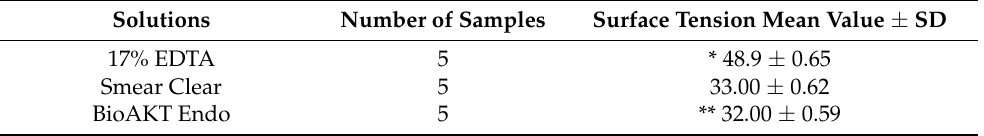
Table 2. Surface tension values (mJ/m 2 ) of the irrigating